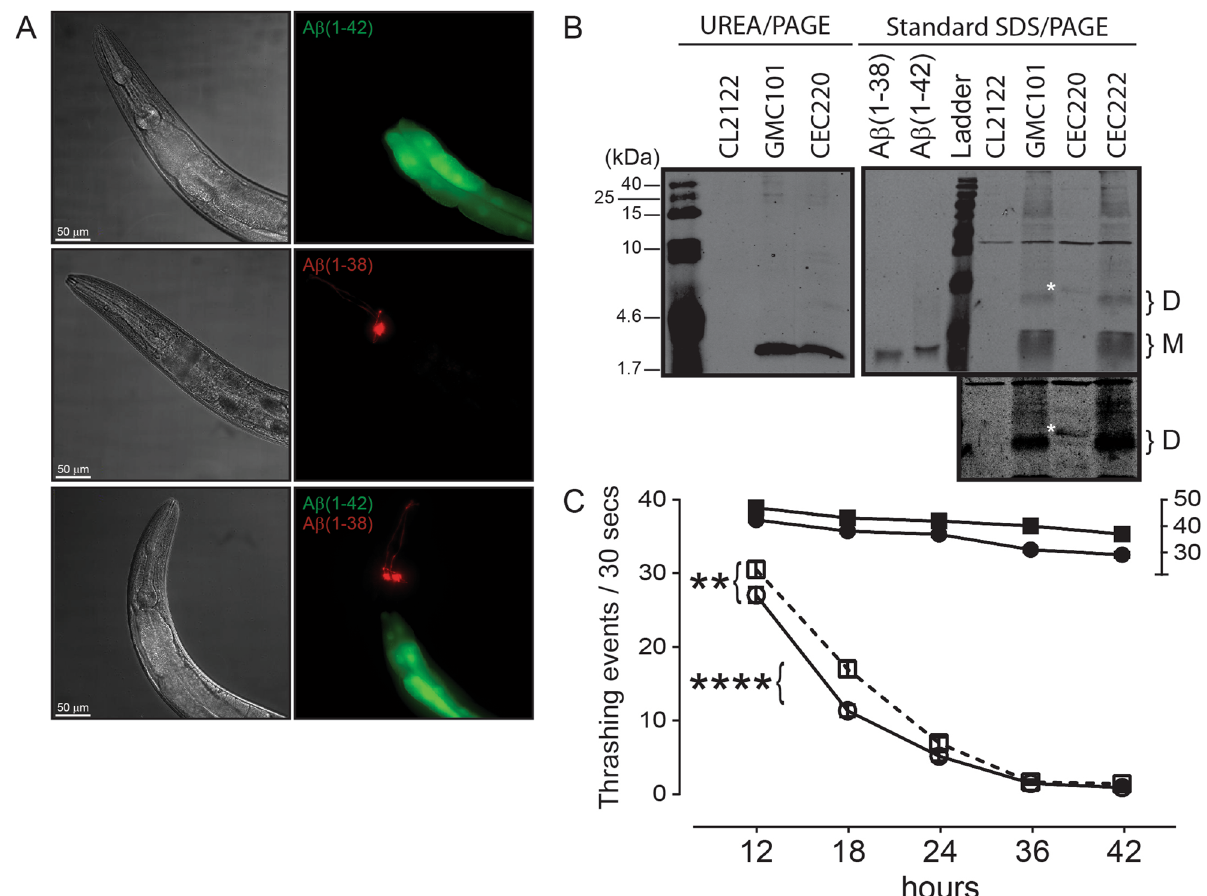
Figure 6. Aβ(1–38) can partially suppress Aβ(1–42)-dependent muscle deterioration in C. elegans . ( A ) Representative images of the anterior region of worms overexpressing untagged Aβ peptides in body wall muscle. DIC images ( left panels ) and live fluorescence ( right panels ) represent: Aβ(1–42) (GMC101 strain; transgene marked by GFP (green) in the intestine), Aβ(1–38) (CEC220 strain; transgene marked by DsRed (red) in head neurons), and a double transgenic animal (CEC222 strain) expressing both Aβ(1–42) and Aβ1(- 38) peptides (both green and red markers present). Scale bar, 50 μm; magnification, 50X. ( B ) Representative immunoblot of UREA/SDS-PAGE resolved extracts showing the expression of Aβ(1–42) in the GMC101 strain and Aβ(1–38) in the CEC220 strain. The protein ladder (in kDa) is indicated on the left. Extracts were also resolved by standard 15% SDS-PAGE and reveal putative monomers (M) and dimers (D). A band in the CEC220 extract (identified with white asterisk ‘*’) likely represents a modified Aβ(1–38) dimer, which is seen more clearly in a longer exposure ( lower panel ). ( C ) Time-dependent changes in the thrashing rates in CL2122 (control) worms (filled circle) and worms expressing Aβ(1–38) (filled square) (relative to the ‘30–50’ segment on the right Y-axis) as well as in the Aβ(1–42)-expressing GMC101 strain ( ○ ), and worms co-expressing Aβ(1–38) and Aβ(1–42) phenotype ( □ ). Two-way ANOVA shows that all groups were significantly different from their respective control groups (n = 60–90; mean ± sem). **: P = 0.01; ****: P = 0.0001 between indicated